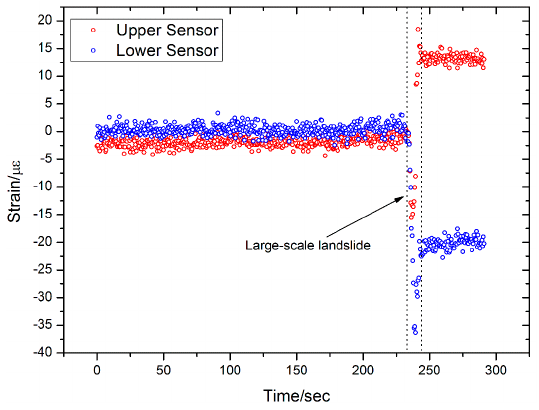
Figure 14. Results from Sensor 1.